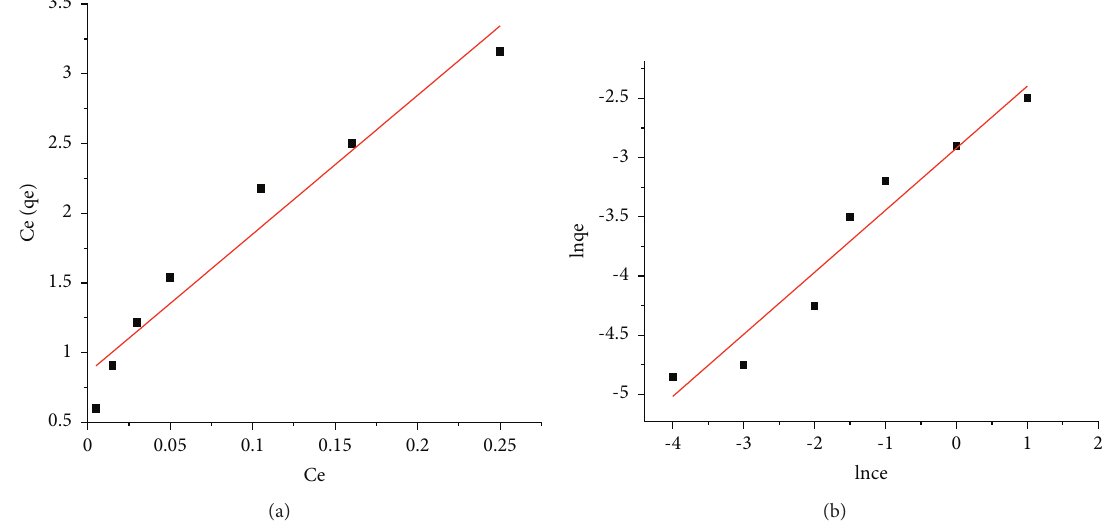
Figure 9: Adsorption isotherm of activated carbon of corncob for adsorption of fluoride: (a) Langmuir isotherm; (b) Freundlich isotherm.